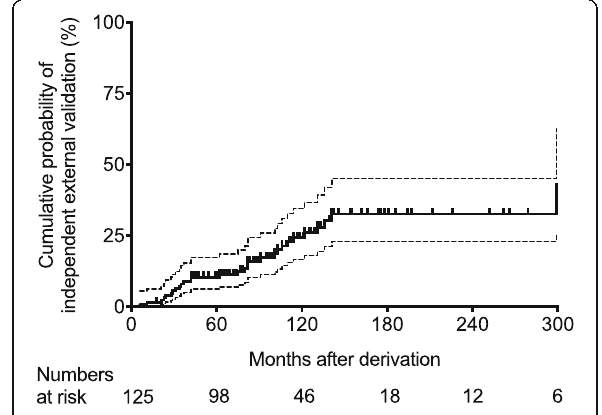
Fig. 2 Probability for a cardiovascular risk clinical prediction rule (CPR) to have an independent external